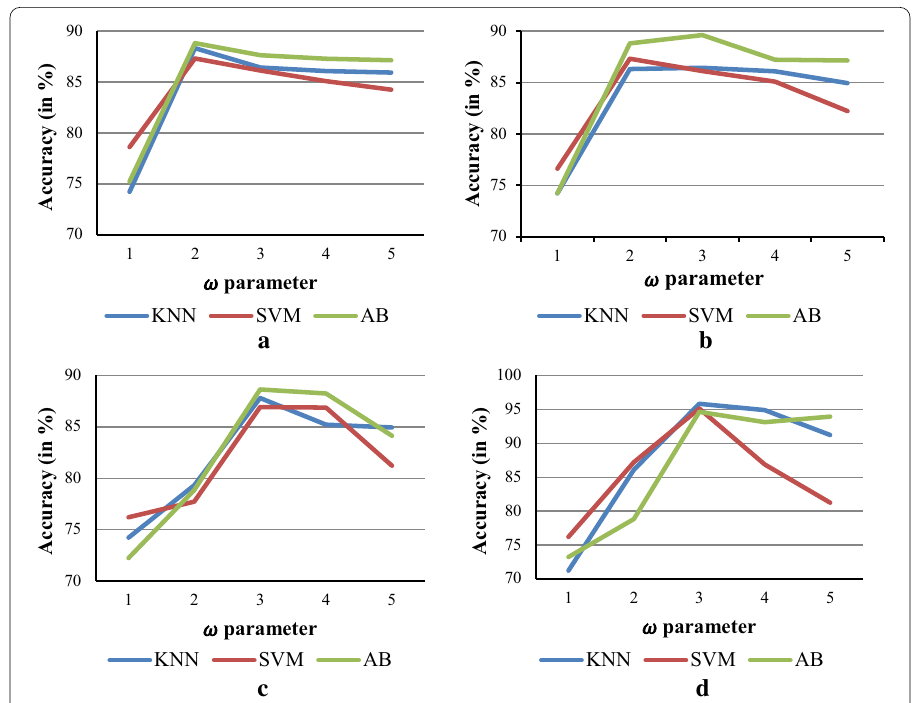
Fig. 9 Average classification accuracy (in %) over ten independent runs, with different δ values in KNN, SVM, and AB classifier on a Sonar dataset, b Arrhythmia dataset, c Madelon dataset, and d Colon